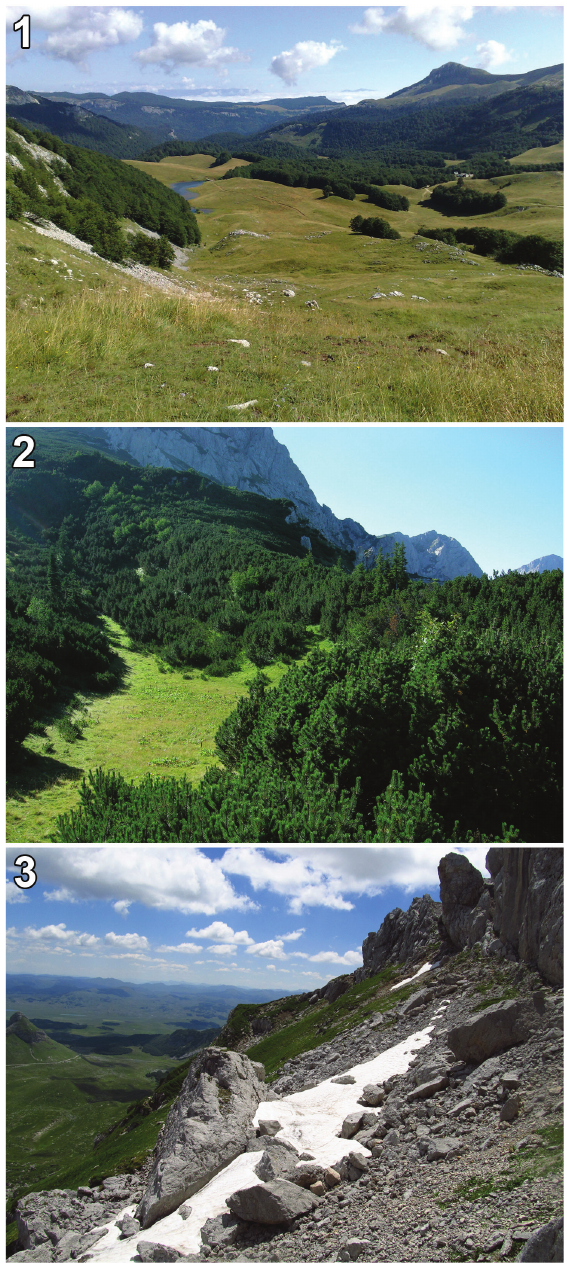
Figures 1–3. Some of the type localities of Omphreus ( Omphreus ) morio sandeli ssp. n. ( 1, 2 ) and O . ( O .) morio durmitorensis ssp. n. ( 3 ). 1 eastern Bosnia and Herzegovina, southern slope of Mt. Zelen- gora, Čemerno, 1,450 m a.s.l., near Gacko (photo Franco Sandel) 2 eastern Bosnia and Herzegovina, Mt. Maglić, Tjentište, 1,450 m a.s.l., near Foča (photo Franco Sandel) 3 northwestern Montenegro, Mt. Durmitor, Sedlo pass, 2,100–2,200 m a.s.l., near